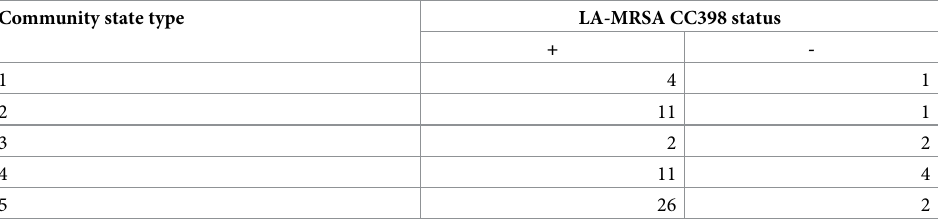
Table 4. LA-MRSA CC398 carriage vs. community state type among pig farm workers. Community state